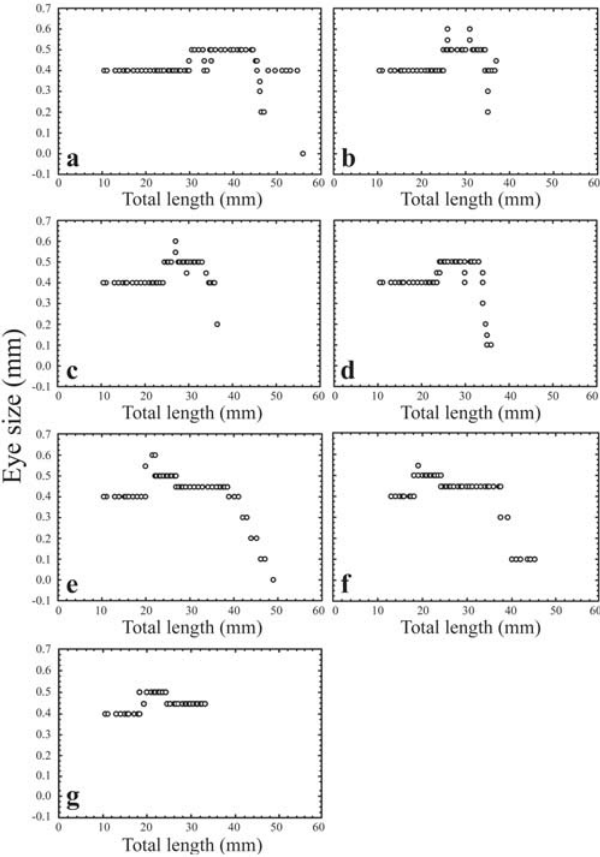
Fig. 4. Size (total length, in mm) versus age (in days) of two wild caught specimens of Ancistrus cryptophthalmus from Angélica Cave kept in laboratory.